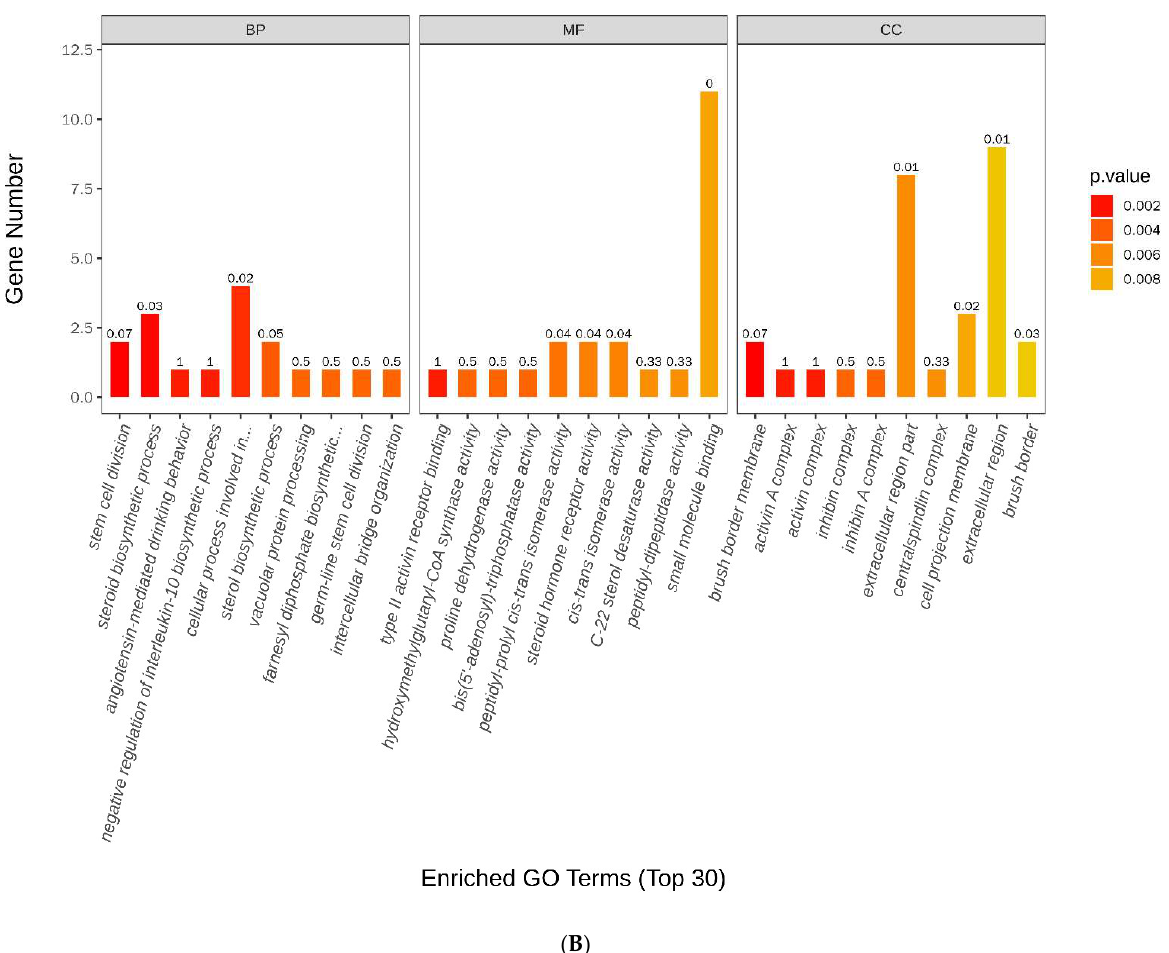
Figure 3. GO terms of different expressed genes for biological process, cellular components and molecular functions between GL16 and YL16 ( A ) or YL16 and YL26 ( B ). GL16 = non−castrated and slaughtered at 16 months of age; YL16 = castrated at birth and slaughtered at 16 months of age; YL26 = castrated at birth and slaughtered at 26 months of age.